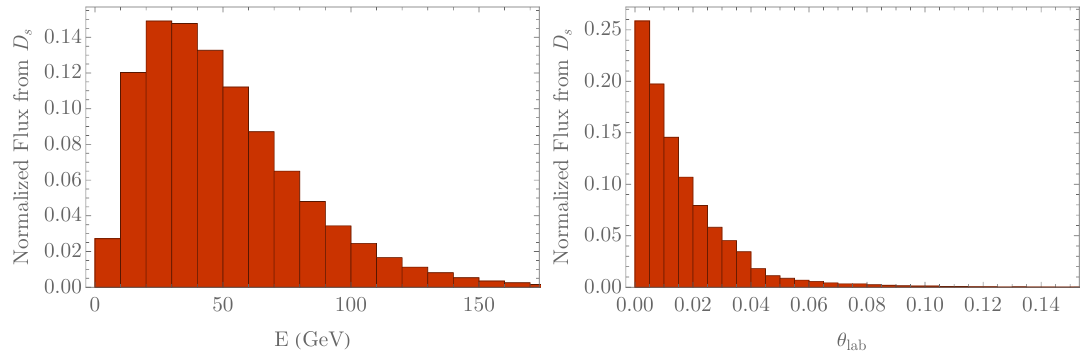
Figure 6 . The branching ratio of D s decaying to ν τ µφ . The red line corresponds to g V = 3 × 10 − 3 and g A = 0 , while the blue line to g V = 0 and g A = 3 × 10 − 3 . Note that the branching ratio is strongly suppressed due to the phase space in the large m φ region, and eventually vanishes for m D − m µ < m φ < m τ + m µ . s